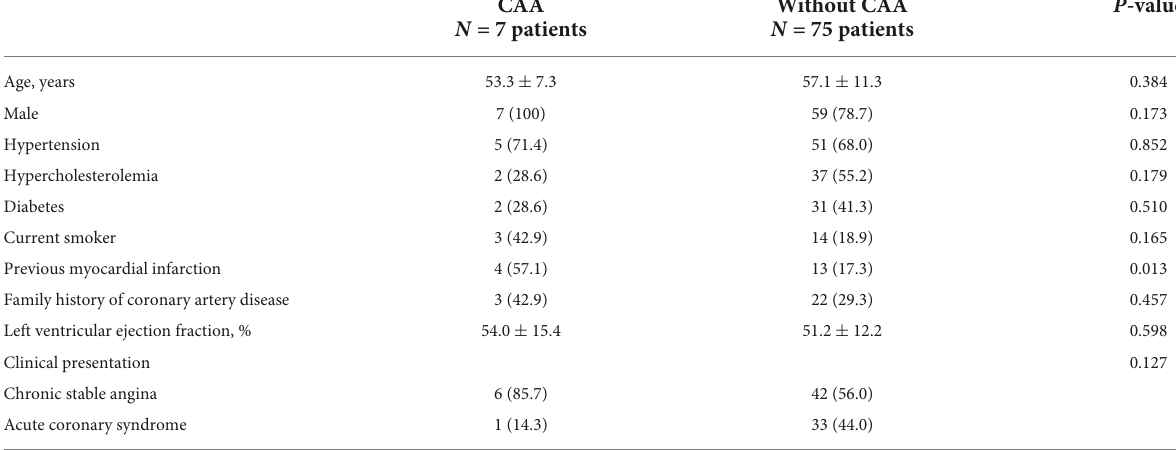
TABLE 1 Baseline patient characteristics according to the presence of aneurysm after DCB-only treatment.